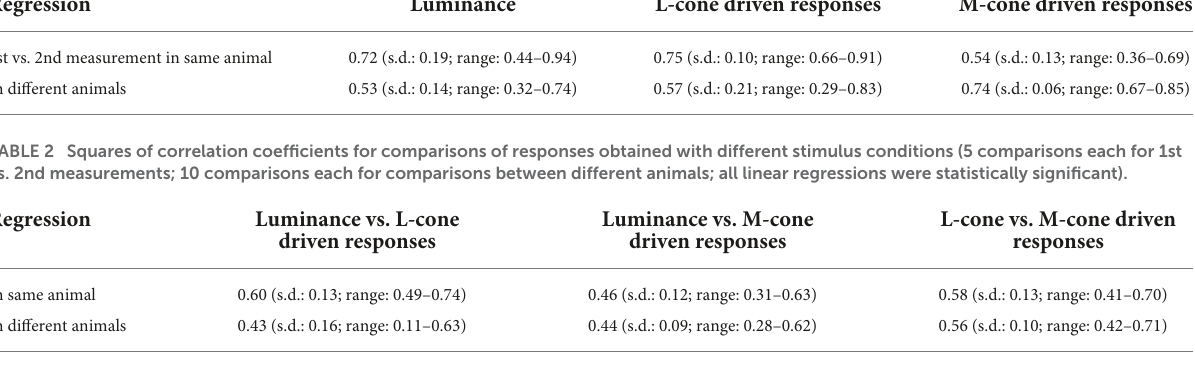
TABLE 1 Squares of correlation coefficients for comparisons of responses obtained with the same stimulus conditions (5 comparisons each for 1st vs. 2nd measurements; 10 comparisons each for comparisons between different animals; all linear regressions were statistically significant). Regression Luminance